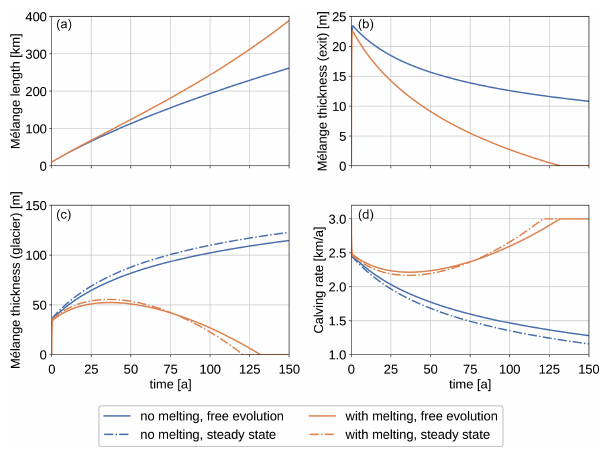
Figure 4. Panels (a) and (b) show the numerical solutions of mélange length, L(t) , and mélange thickness at the embayment exit, d( 0 ,t) , given by Eqs. (11)–(14). Two scenarios are consid- ered: without melting (blue line) and with melting (orange). Pan- els (c) and (d) show the mélange thickness at the calving front, d(L(t),t) , and the resulting buttressed calving rate, C(t) . The solu- tion with free evolution of the mélange geometry (continuous line) is contrasted with the steady-state solution obtained by plugging the mélange length, L(t) , into Eqs. (5) and (6), respectively, (dashed